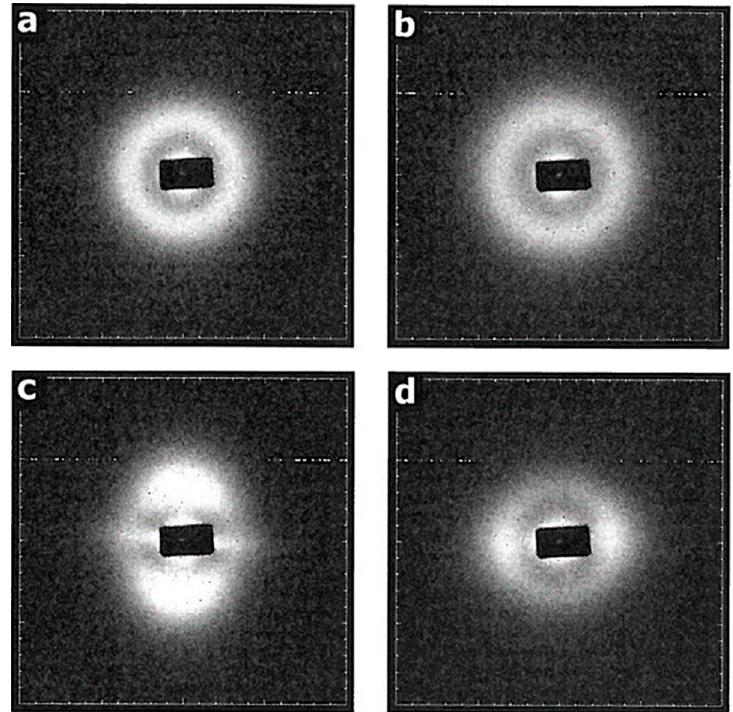
Figure 4. Small-angle X-ray scattering (SAXS) patterns obtained for samples of ( a ) PCL at 20 °C; ( b ) PCL with 3% PVB at 7 °C; ( c ) PCL with DBS at 22 °C and ( d ) PCL with 3% PVB and 3% DBS at 19 °C, all crystallised from a melt after a shear flow of 10 s − 1 for 100 su at 80 °C. The melt flow direction is vertical. Each pattern is shown for the temperature where the invariant recorded during crystallisation was at its maximum.